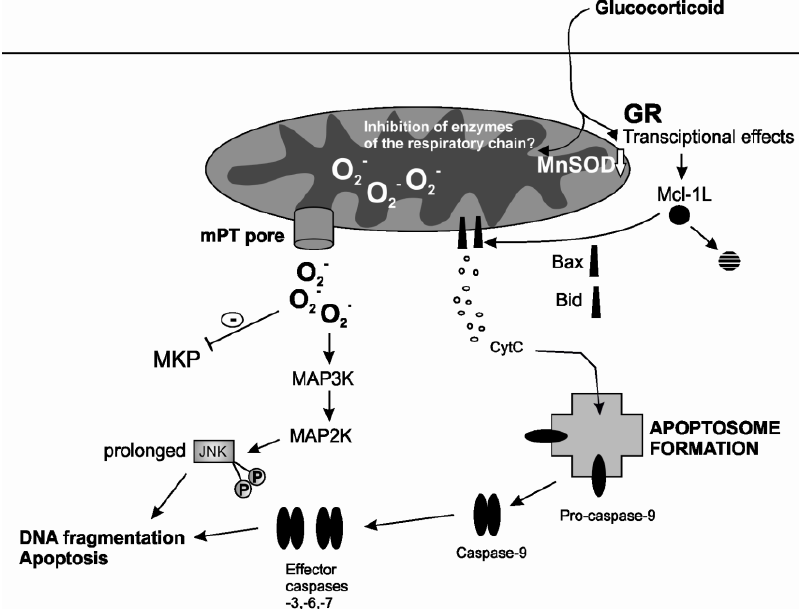
Figure 2. A proposed model of the pro-apoptotic mechanism of glucocorticoids in eosinophils. Glucocorticoid-induced eosinophil apoptosis is partially dependent on glucocorticoid receptor and stimulate an intrinsic pathway of apoptosis. Transcriptional effects may lead to reduced level of mitochondrial antioxidant MnSOD and elevated ROS. It is also possible that glucocorticoids directly inhibit mitochondrial respiratory chain enzymes. Elevated ROS may lead to mPT and release of ROS to the cytosol. ROS inhibits MKP and stimulates activation of the MAPK pathway. Glucocorticoids may also enhance degradation of anti-apoptotic Mcl-1L by a transcriptional route. Degradation of Mcl-1L enables oligomerization and pore-forming activity of Bax leading to mitochondrial outer membrane permeabilization. Processing of pro-apoptotic Bid into its truncated, pore-forming fragment is also enhanced by glucocorticoids. Abbreviations: GR, glucocorticoid receptor; Mcl-1L, myeloid cell leukemia 1 (long); MnSOD, manganese superoxide dismutase; mPT, mitochondrial permeability transition; CytC, cytochrome c; MKP, map kinase phosphatase; JNK, c-Jun N -terminal kinase; MAP3K, mitogen-activated protein kinase kinase kinase; MAP2K, mitogen-activated protein kinase